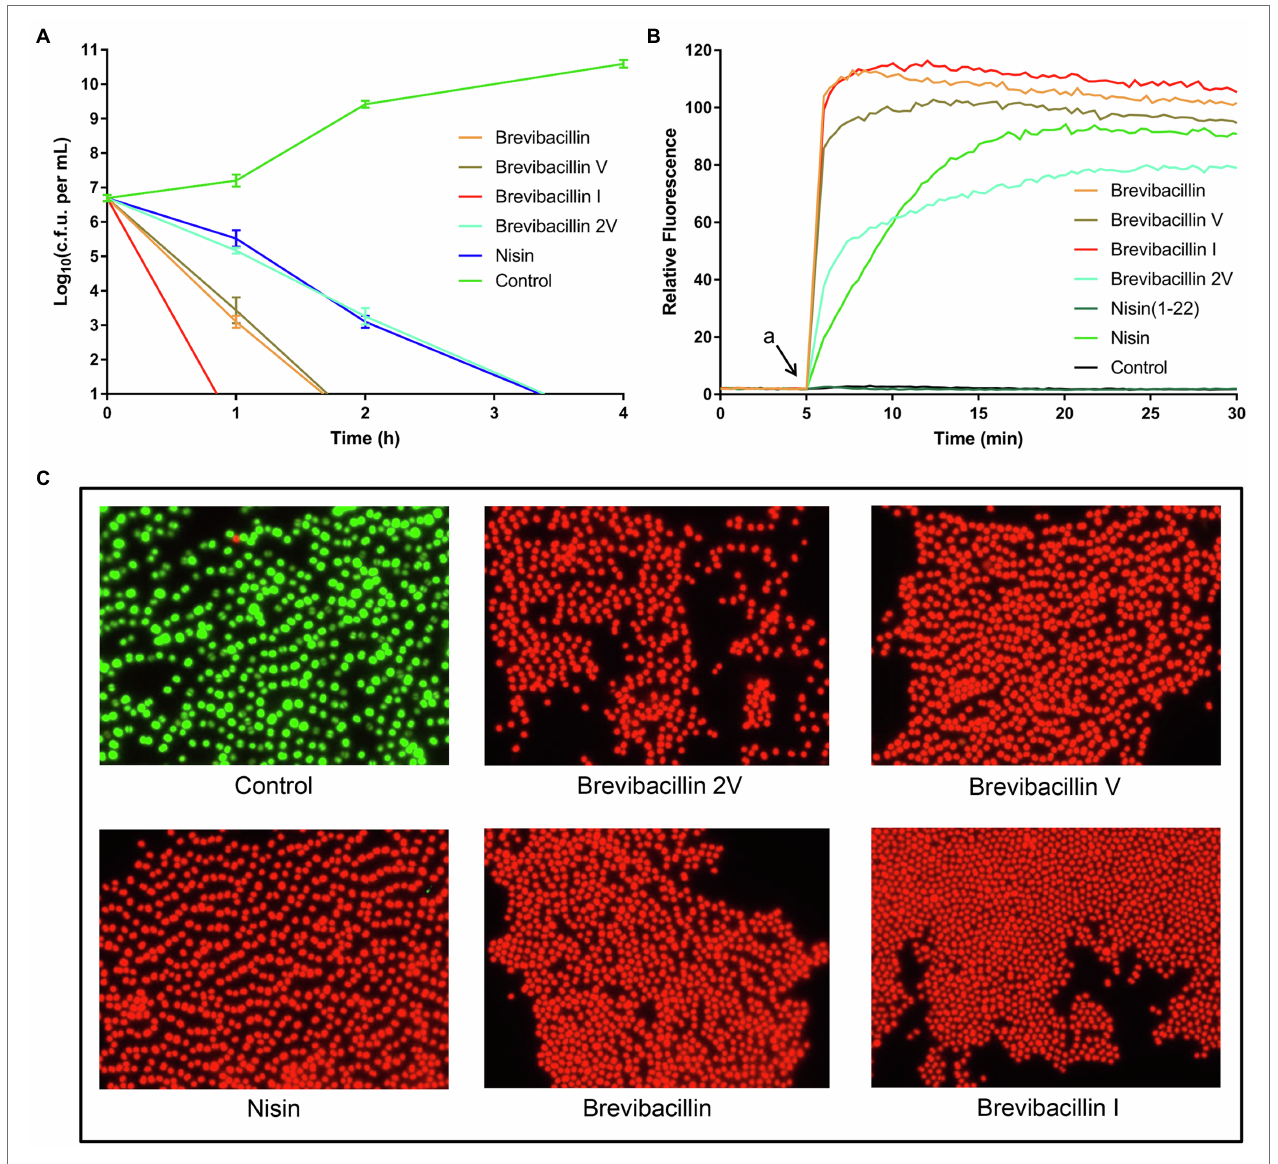
FIGURE 3 | Brevibacillins disrupt the cellular membrane and act as bactericidal antibiotics. (A) , time-killing curves of brevibacillins (10 × MIC) against S. aureus (MRSA). (B) , DiSC 3 (5) fluorescence in S. aureus (MRSA) upon exposure (at 2 × MIC) to brevibacillins, nisin, nisin (1-22), and MQ (Control); a, when peptides were added. (C) , fluorescence microscopic images of S. aureus (MRSA) treated by brevibacillins and nisin at a concentration of 2 × MIC for 15